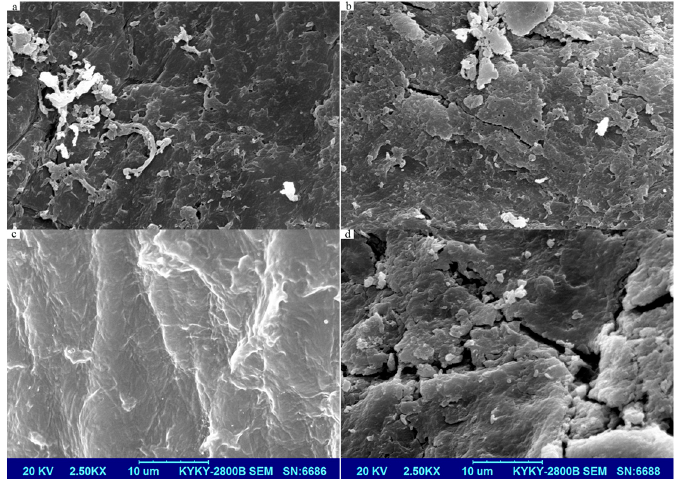
Figure 4. Surface morphology of ATUCS ( a ); CATUCS ( b ); MTACS ( c ); and CMTACS ( d ).